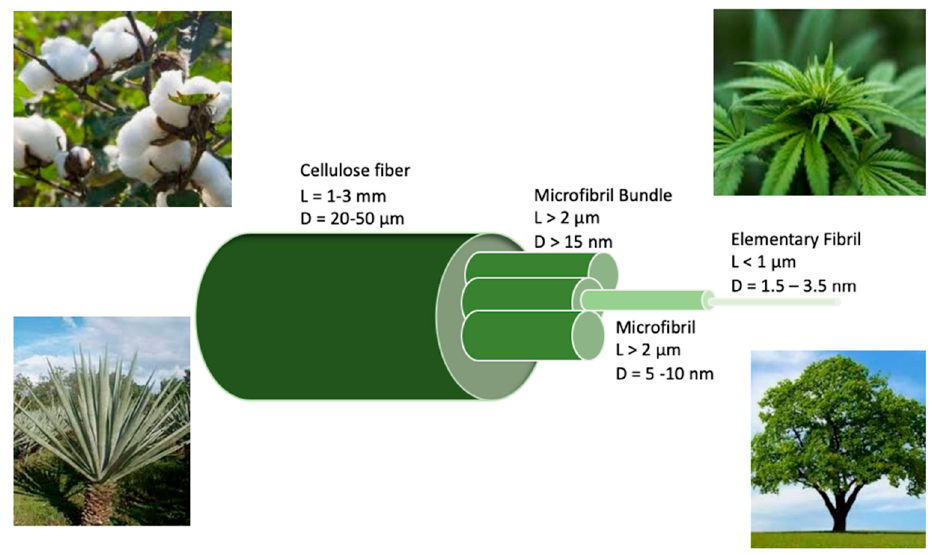
Figure 2. Hierarchical structures of cellulose fibers.